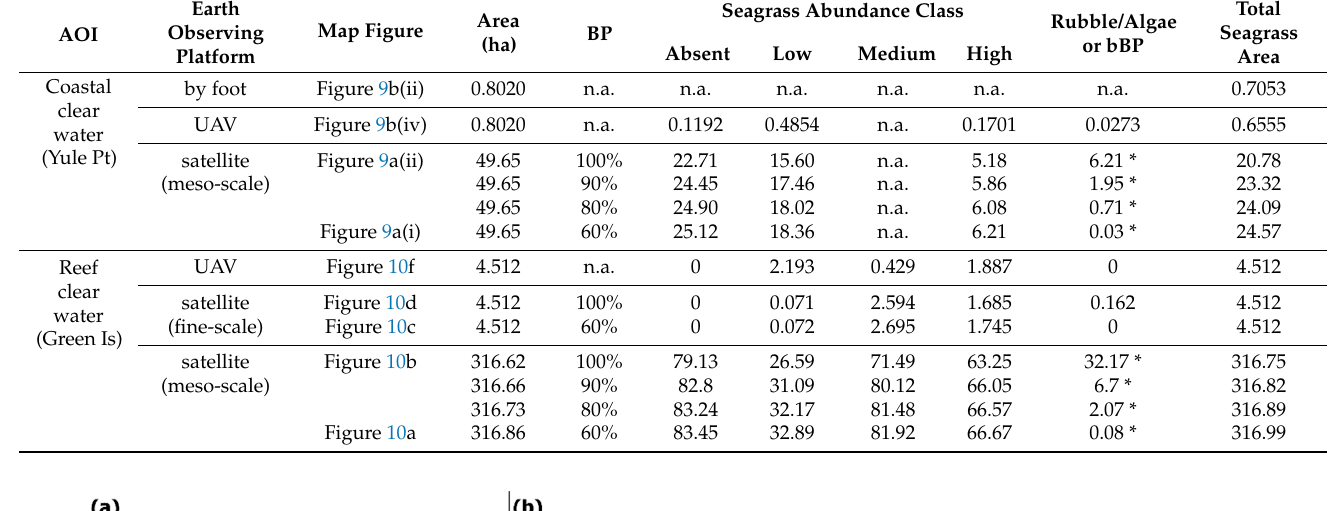
Table 7. Area of seagrass abundance classes (hectares) mapped within each AOI at reef and coastal clear water habitats using imagery captured with satellite (PlanetScope) and UAV. BP = bootstrap probability, * = below bootstrap probability (bBP). AOI for meso-scale spaceborne-captured imagery can differ due to kernelling at the margins of the AOI. n.a. = not assessed. NB: reef clear water meadow covers entire AOI, with no meadow boundary mapped by foot.